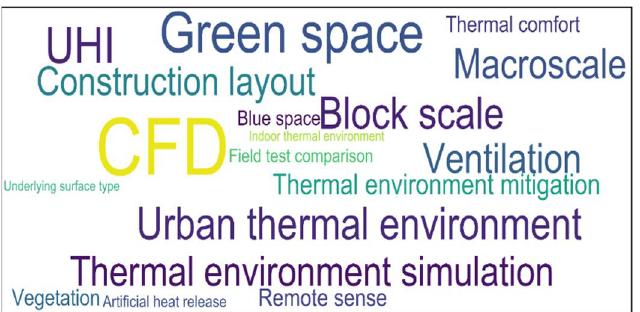
Figure 1. Word cloud diagram of keywords from CFD-based thermal environment research.